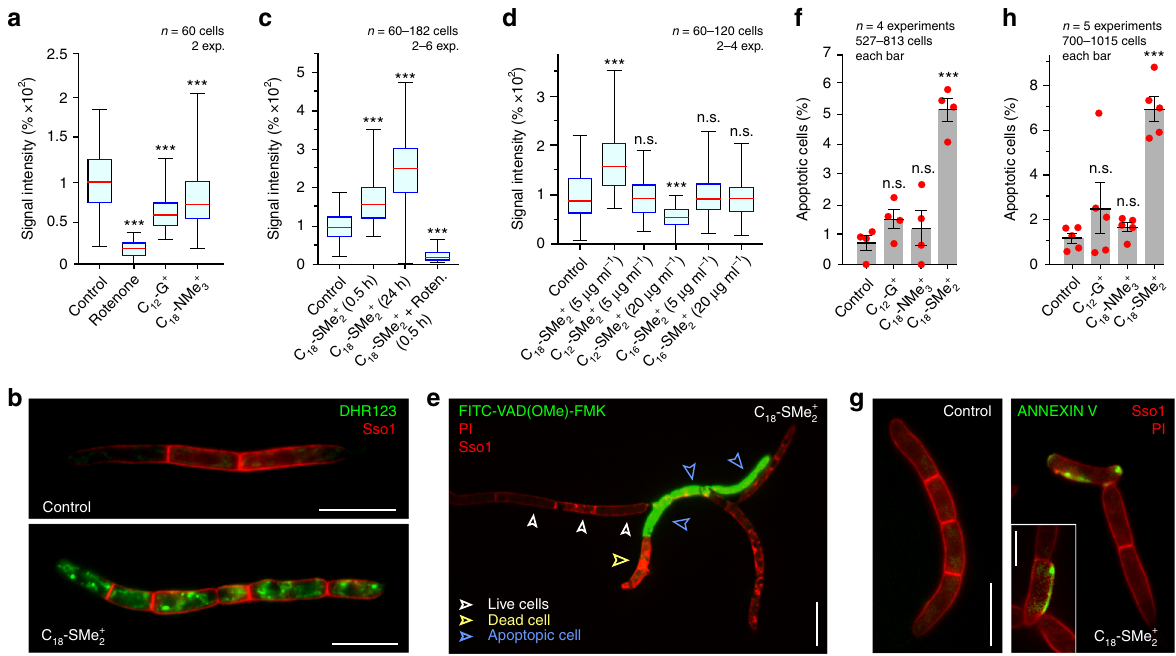
Fig. 5 C 18 -SMe 2 + -induced ROS production and programmed cell death in Z. tritici . a Quantitative comparison of DHR-123 staining of mROS in Z. tritici cells, treated for 30 min with solvent (Control), the complex I inhibitor rotenone, or C 12 -G + and C 18 -NMe 3 + . b DHR-123 staining of mROS in Z. tritici cells, treated with solvent (Control) and C 18 -SMe 2 + . The plasma membrane is labeled by mCherry-Sso1. Note that the red- fl uorescence images were scaled identically. Scale bars = 10 µ m. c mROS production in Z. tritici in presence of solvent control (Control), 30 min treatment with C 18 -SMe 2 + (C 18 -SMe 2 + , 0.5 h), and 24 h treatment with C 18 -SMe 2 + (C 18 -SMe 2 + , 24 h), and co-treatment with rotenone and C 18 -SMe 2 + (C 18 -SMe 2 + + Roten., 0.5 h). d mROS production in Z. tritici after treatment with solvent (Control), C 12 -SMe 2 + , C 16 -SMe 2 + , and C 18 -SMe 2 + , at 5 µ g ml − 1 or 20 µ g ml − 1 . See also Supplementary Fig. 6. e Apoptotic Z. tritici cells, detected by CaspACE FITC-VAD-fmk. Healthy cells exclude the dye (open white arrowheads), whereas apoptotic cells are fi lled with green- fl uorescence (open blue arrowheads). Post-apoptotic cells that contain propidium iodide were not included in the analysis (yellow open arrowhead). The plasma membrane is visualized by the marker mCherry-Sso1 (red). Scale bar = 10 µ m. f Number of early apoptotic Z. tritici cells (CaspACE FITC-VAD-fmk-positive, but propidium iodide-negative), treated with the solvent, C 12 -G + , C 18 -NMe 3 + , and C 18 -SMe 2 + . g Apoptotic Z. tritici cells, detected by Annexin-V- fl uorescein staining. Healthy cells are unstained (left panel), whereas apoptotic cells expose phosphatidylserine and show green- fl uorescence at their plasma membrane (right panel; plasma membrane in red, labeled with mCherry-Sso1). Post-apoptotic cells were identi fi ed by double staining with propidium iodide and excluded from the analysis. Scale bars = 10 µ m (left panel), 5 µ m (insert, right panel). h Number of early apoptotic Z. tritici cells (Annexin-V- fl uorescein-positive, but propidium iodide-negative), treated with the solvent control, C 12 -G + , C 18 -NMe 3 + and C 18 -SMe 2 + . a , c , d Whiskers ’ plots, with 25th/75th percentiles (blue lines), medians (red line), and minimum and maximum (whiskers ends). Values f , h are shown as mean ± SEM. Red dots represent data points. Sample size n is indicated in each panel. Non-parametric Mann – Whitney testing ( a , c , d ); n.s. non-signi fi cant difference to control ( P > 0.05) ( d ), *** P < 0.0001 ( a , c , d ). Student ’ s t -testing with Welch correction ( f , h ); n.s. non-signi fi cance ( f , h ) and *** P = 0.0002 ( f , h ). All P -values are two-tailed. See Supplementary Table 7 for experimental conditions. All source data are provided as a Source Data fi